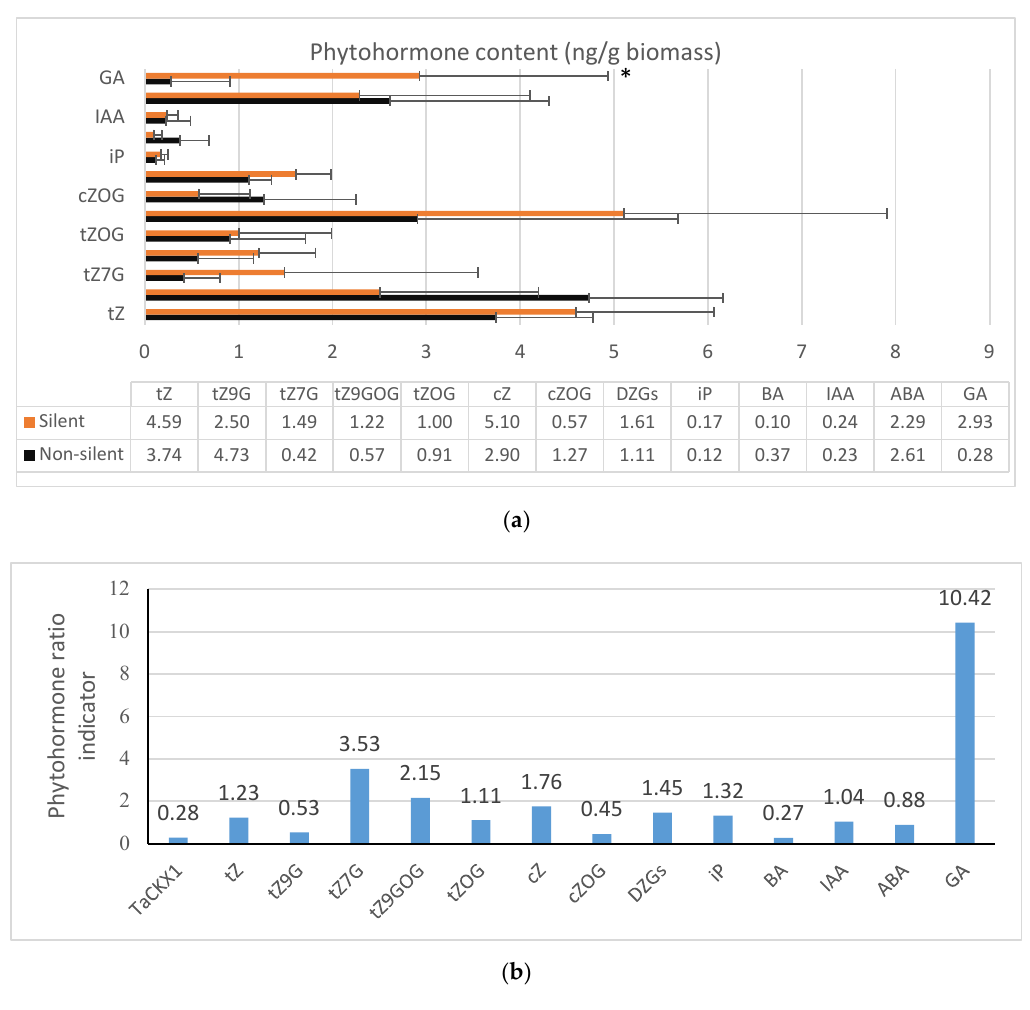
Figure 4. Phytohormone content (ng/g biomass) measured in the group of control and silent T 2 plants ( a ). Phytohormone ratio indicators (mean value in silent per mean value in not silent, control plants) in silent T 2 plants ( b ). *—significant at p < 0.05. Small amounts (≤1.00 ng/g biomass): tZR, tZOGR,